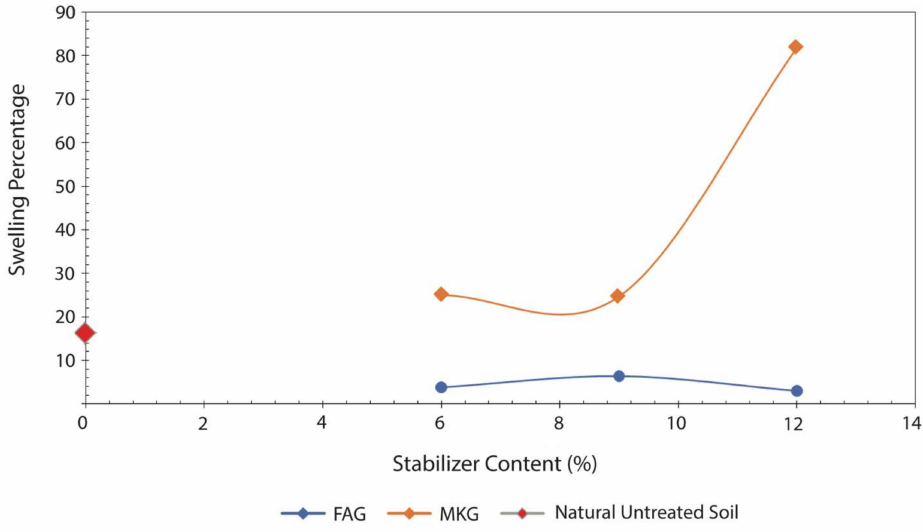
Figure 1. The soil expansion test results of untreated soil in comparison to the soils stabilized with different contents of the FAG and MKG stabilizer. Data after Khadka et al.